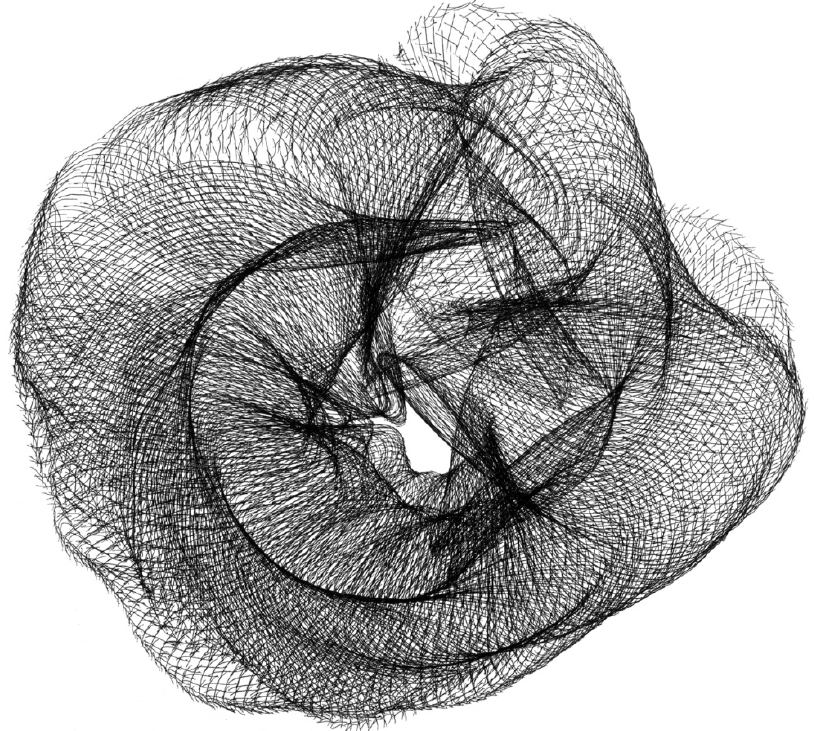
Figures 14. Secondary patterns near chaos from the NTT machine. Figure 14. Secondary patterns near chaos from the NTT